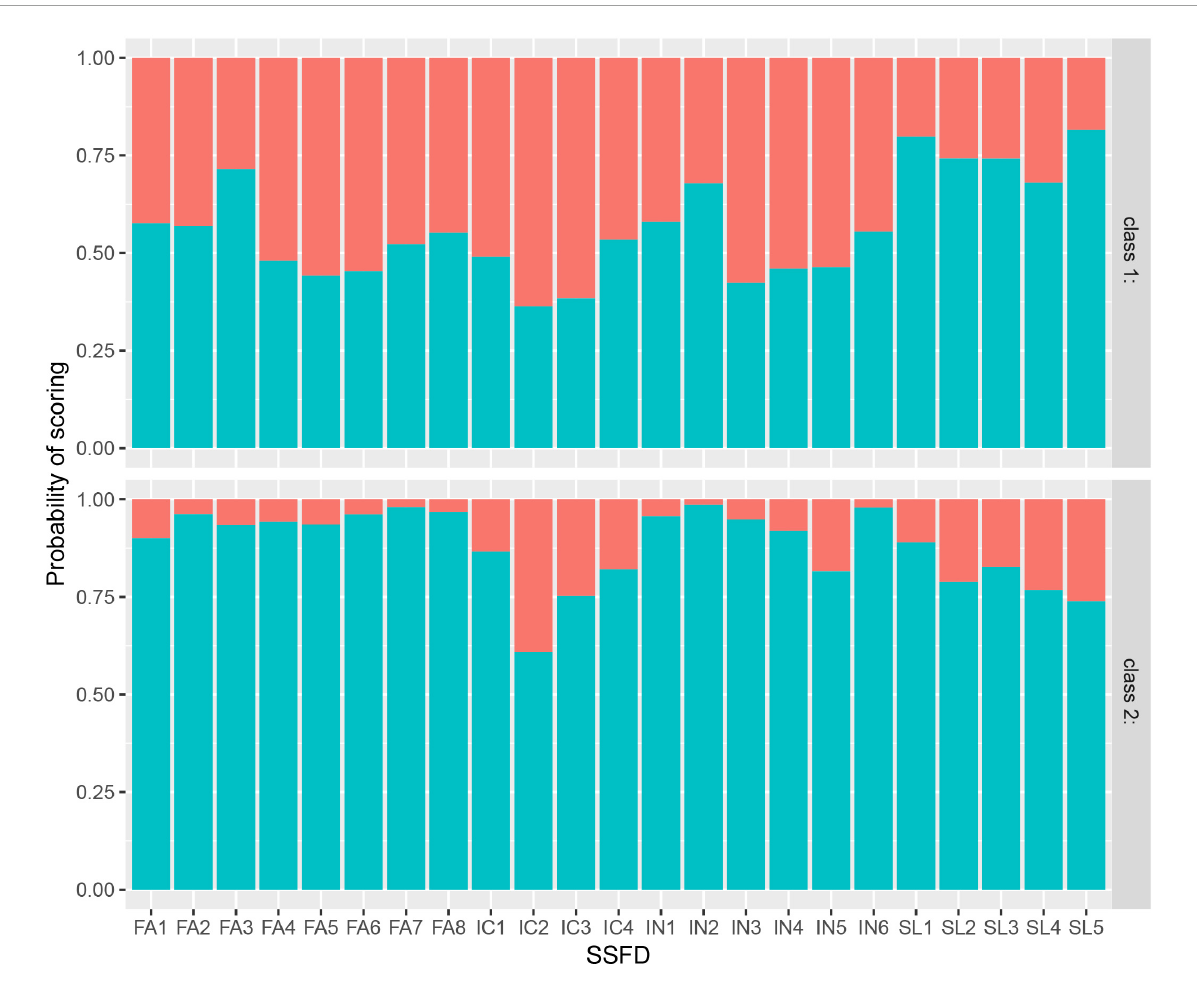
FIGURE1 Response probability values of latent classes of family dynamics in participants.